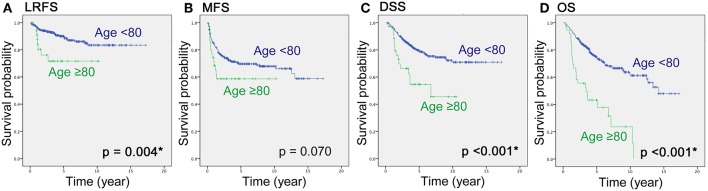
Local-recurrence-free survival (A), metastasis-free survival (B), disease-specific survival (C) and overall survival (D) of high-grade sarcomas in patients aged <80 and ≥80 years, using the Kaplan-Meier method. LRFS, local-recurrence-free survival; MFS, metastasis-free survival; DSS, disease-specific survival; OS, overall survival.